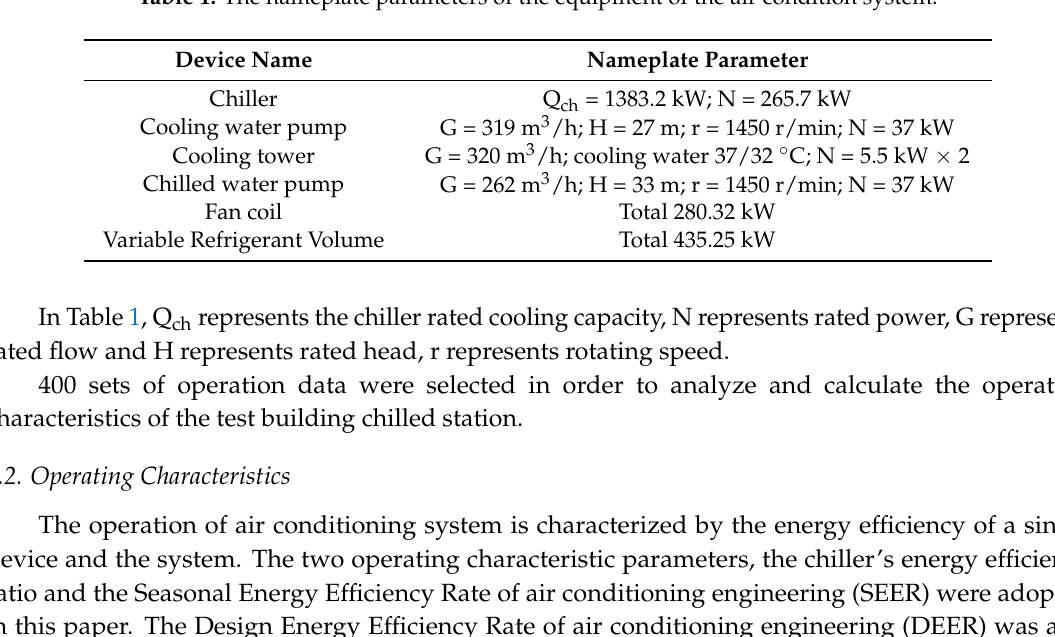
Table 1. The nameplate parameters of the equipment of the air condition